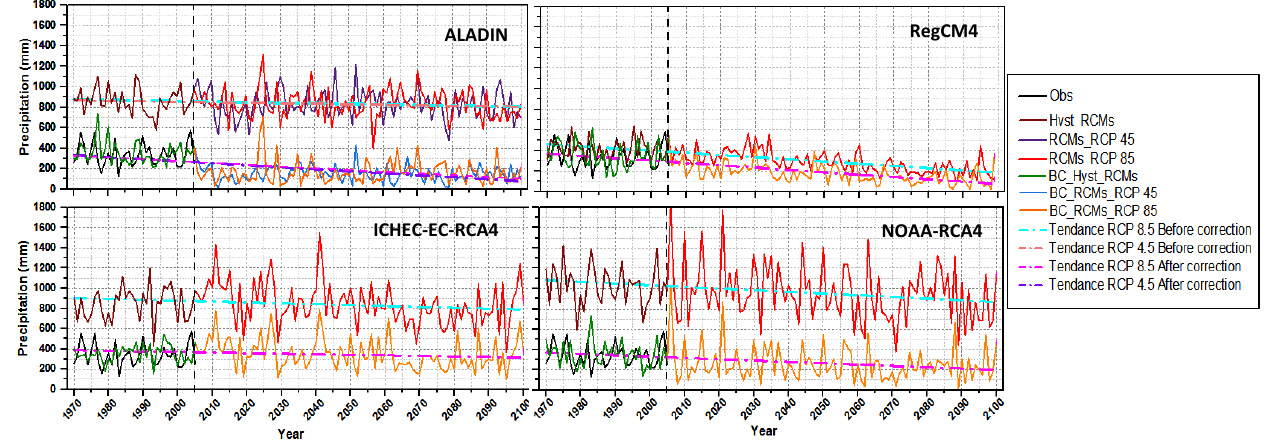
Figure 12. Annual precipitation predicted by RCP 4.5 and RCP 8.5 with trends for predicted raw and corrected RCMs.